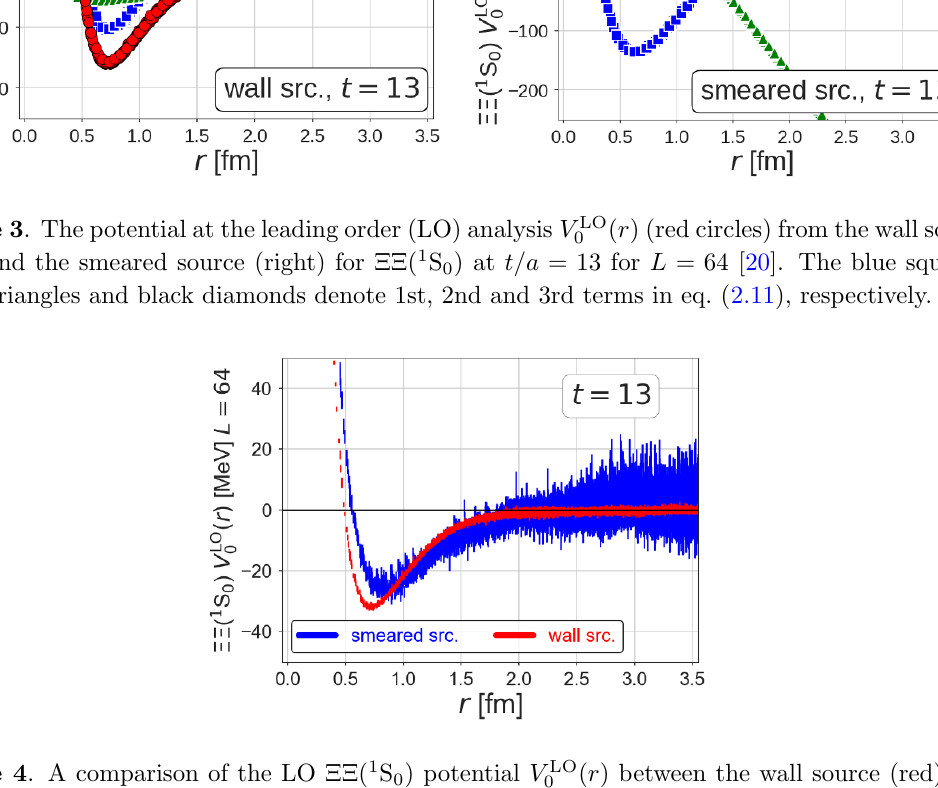
( r ) between the wall source (red) and 0